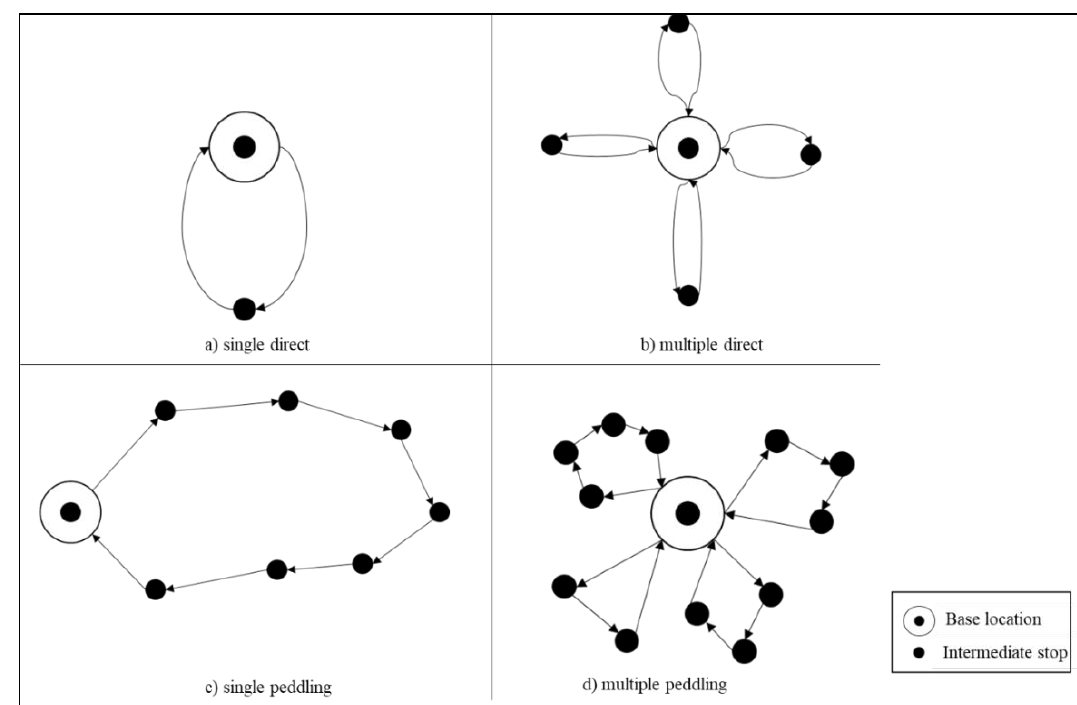
Figure 2. Tour pattern.